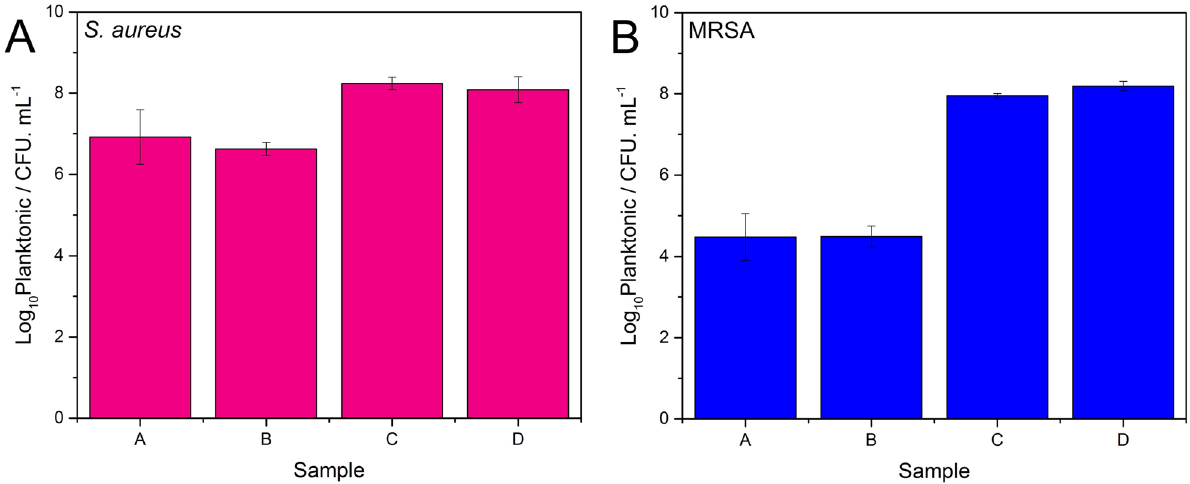
Figure 6. Viability of S. aureus (Panel A ) and MRSA (Panel B ) planktonic cells in the presence of the glass slides. Sample ( A ): PEM with nisin outer layer; Sample ( B ): PEM with nisin/CAR outer layer; Sample ( C ): PEM without nisin and; Sample ( D ): Blank glass slide. The data are from a minimum of two biology experiments, with two replicates in each (i.e. at least 4 measurements in each case).